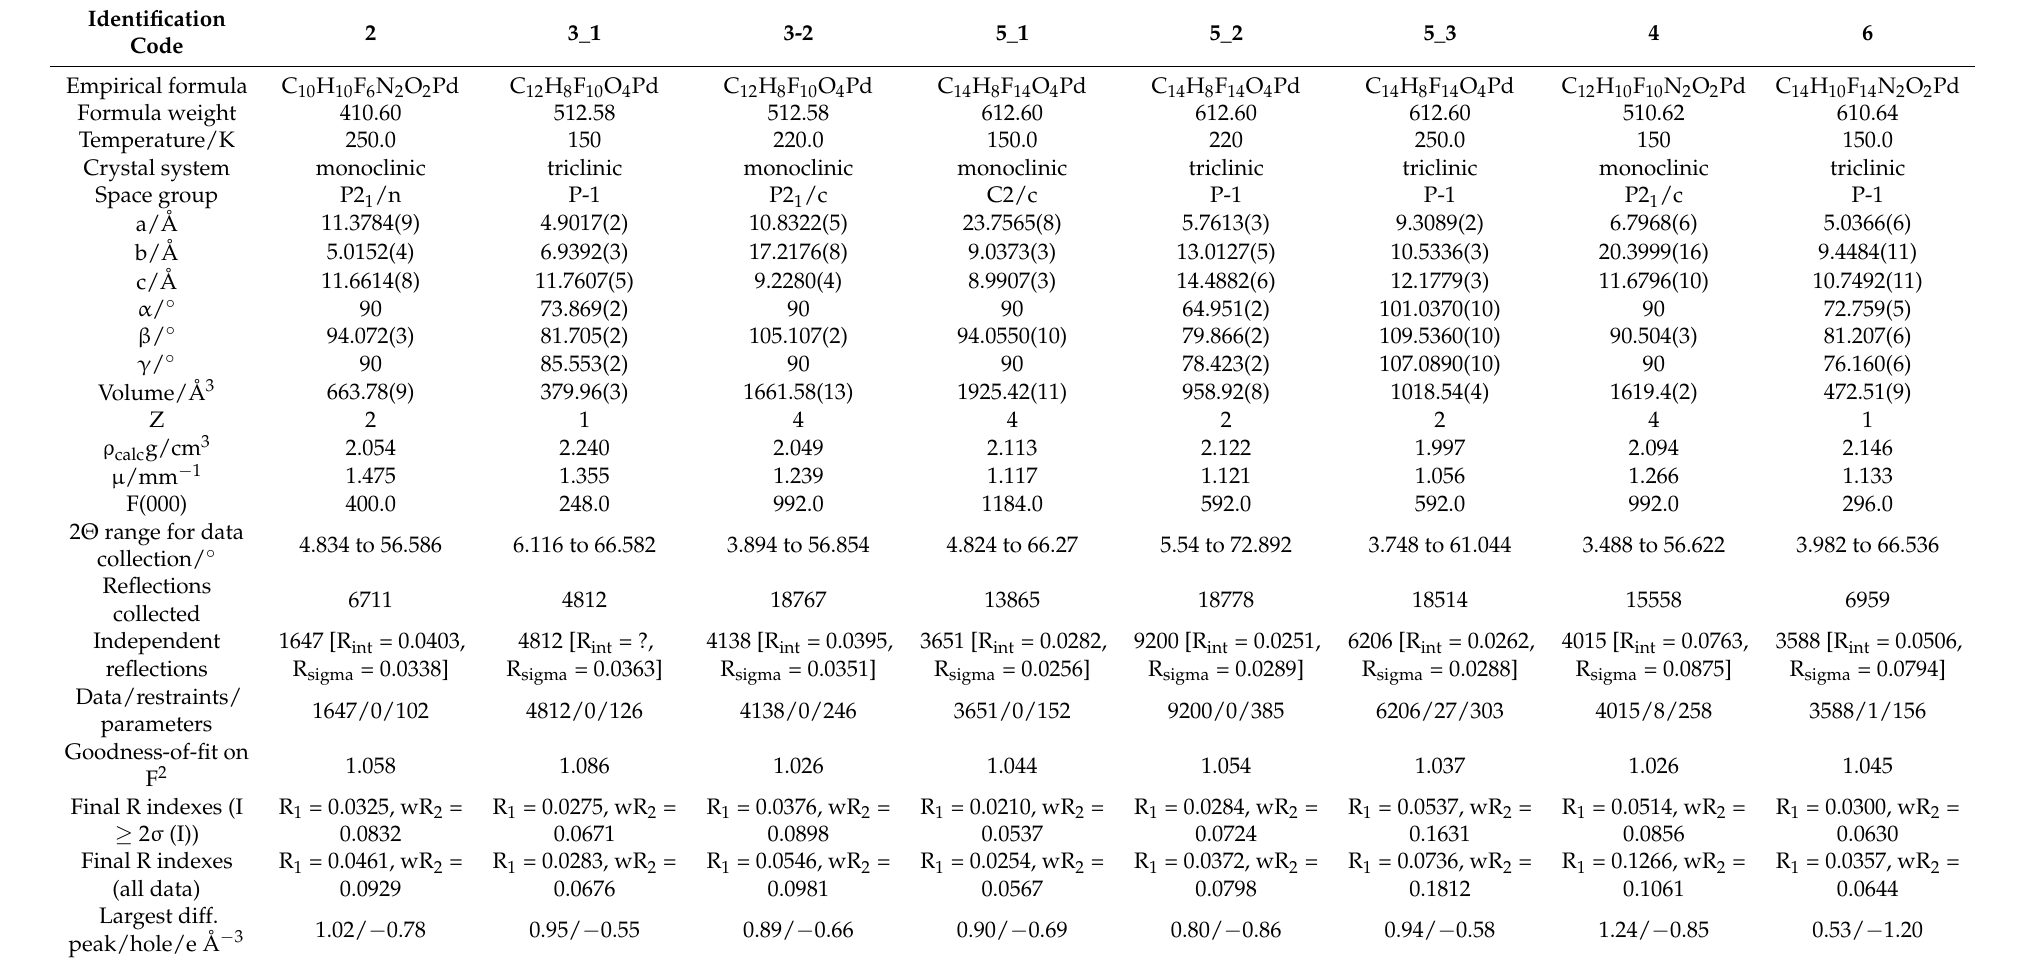
Table 3. Unit cell parameters and refinement